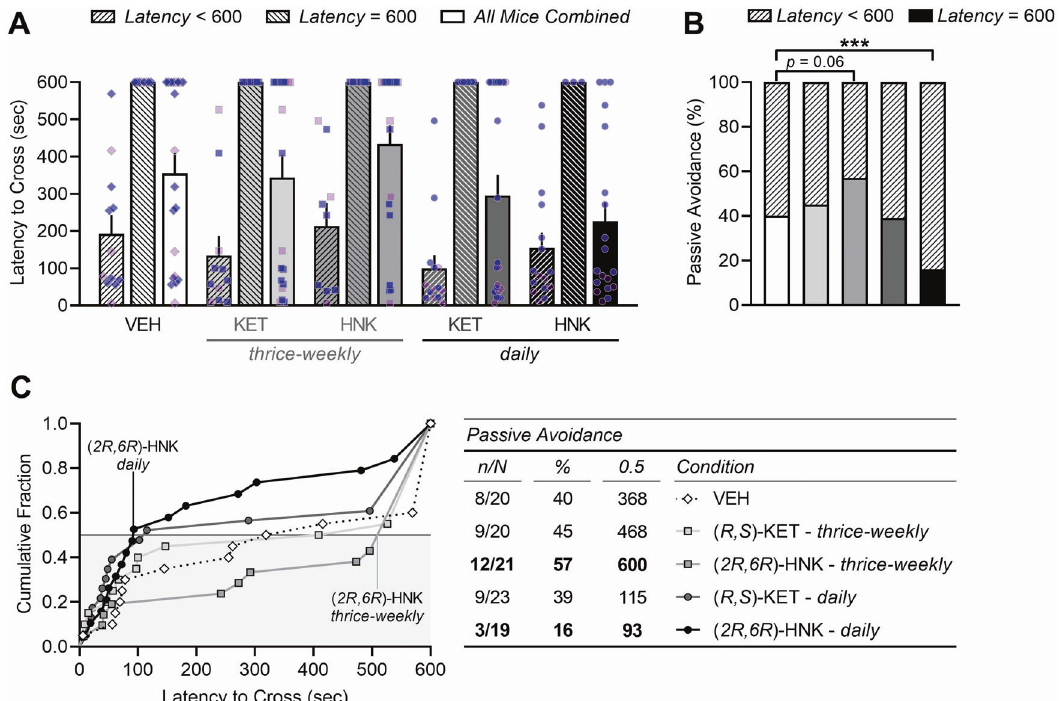
Fig. 6 Daily ( 2R,6R )-hydroxynorketamine treatment impairs implicit memory in the passive-avoidance task while thrice-weekly treatment tends to improve it. A Latency to cross into the dark shock-paired chamber during testing. Mice that did not cross during the 10- min procedure (latency = 600 sec) display ( B) “ complete ” passive avoidance, de fi ned as a failure to cross within 600 s. C Drug exposure led to a shift in the cumulative fraction of scores with regard to latency to cross; corresponding values represent the number of animals that did not cross within each condition ( n /N), the percentage of animals that did not cross within each condition (%), and the 50th percentile of scores within each condition (0.5). Data are presented as mean ± standard error of the mean. *** P <